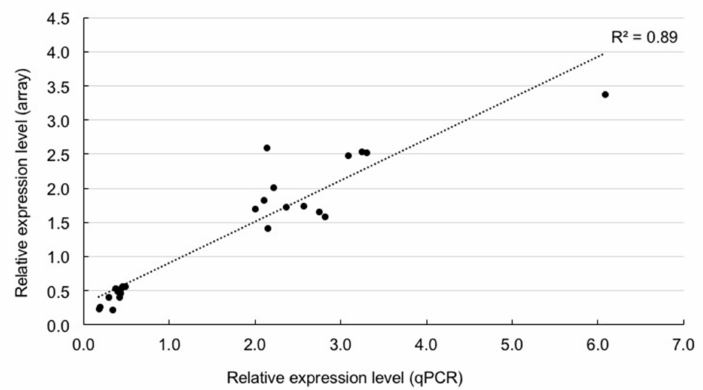
Figure 3. Verification of microarray data by qPCR. Relationship of relative expression levels between qPCR and microarray in 24 di ff erentially expressed genes between big- and medium-sized F 1